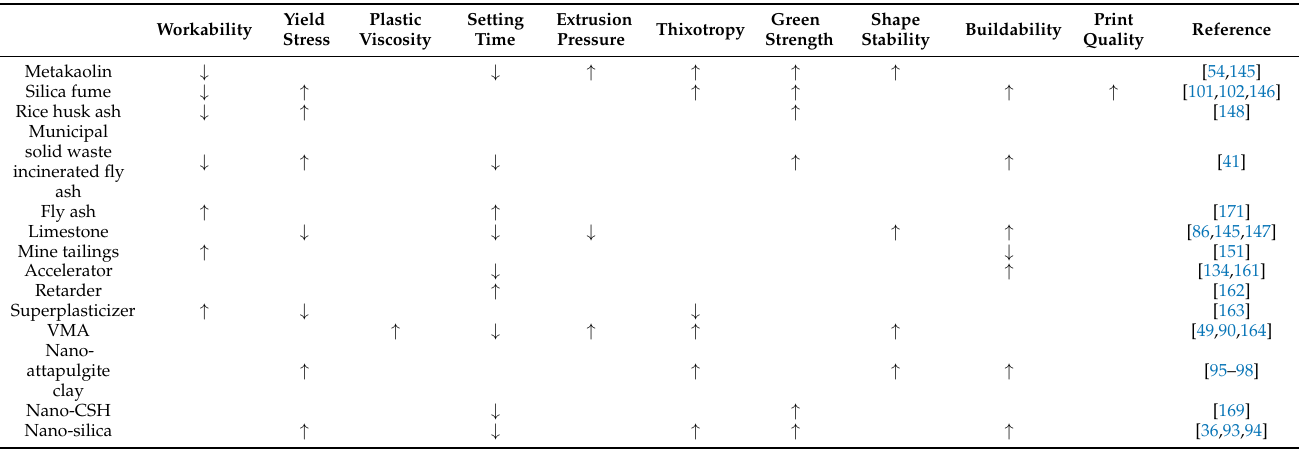
Table 4. Effect of ingredients upon the fresh properties of 3D-printable